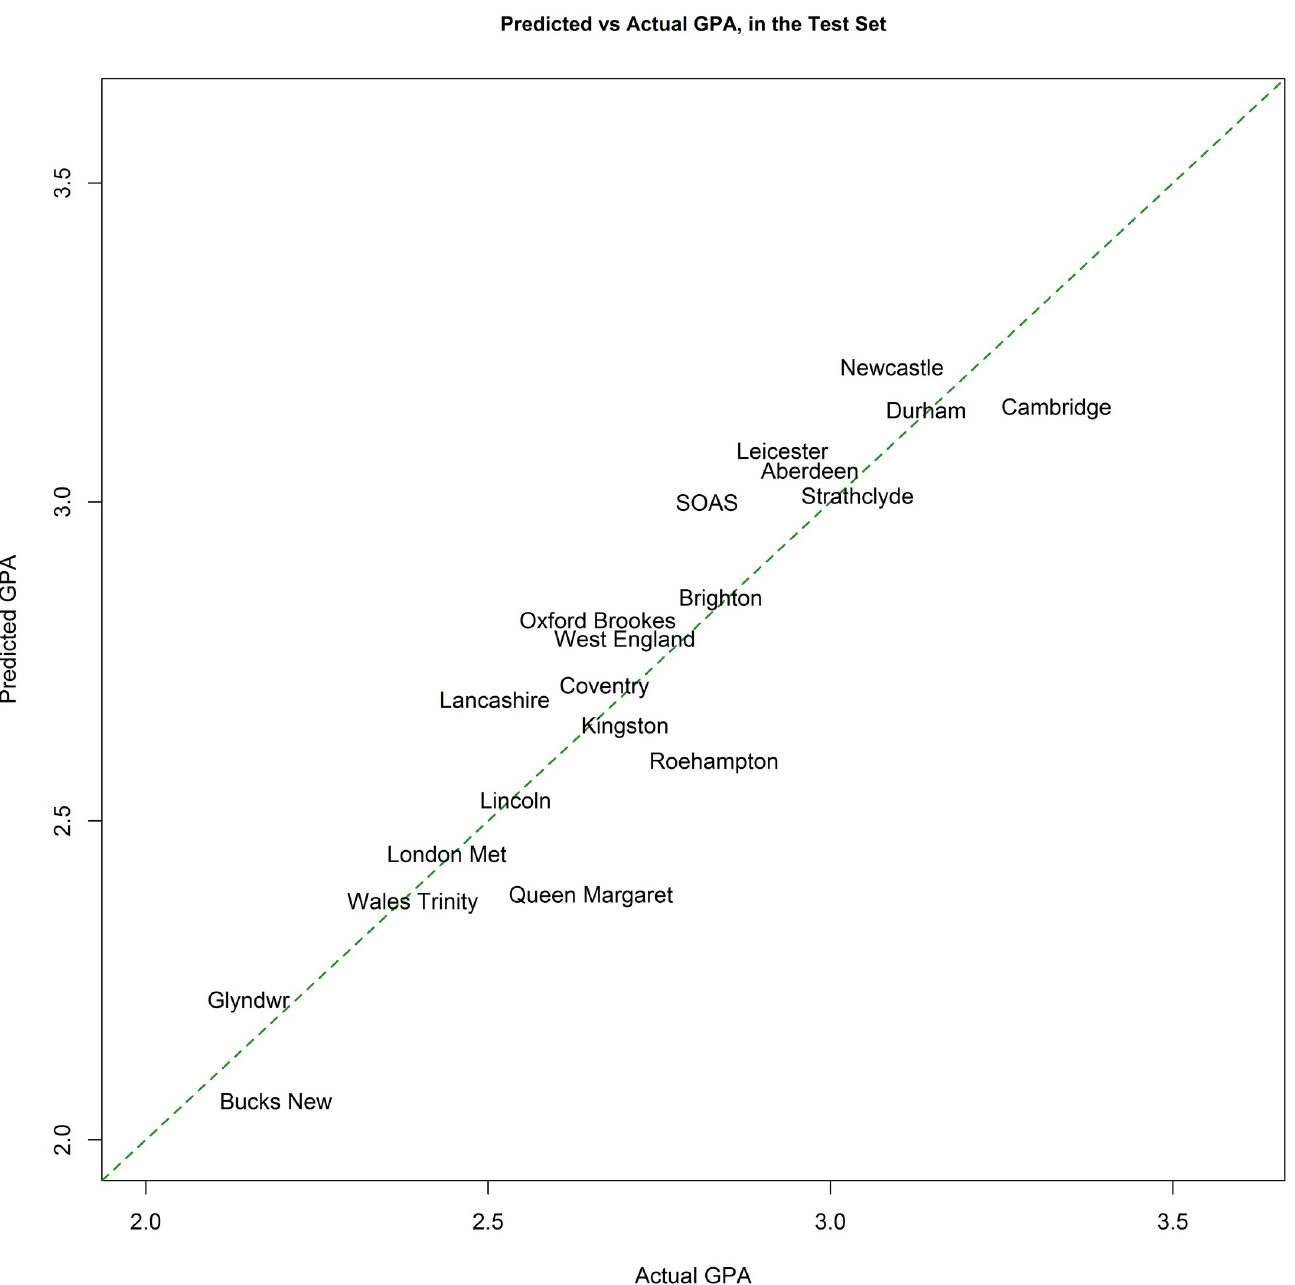
Fig 3. Predicted vs actual GPAs in the testing subset. Some universities are not displayed for clarity. See Table 2 for the complete list of universities in the test set with their actual and predicted GPAs.